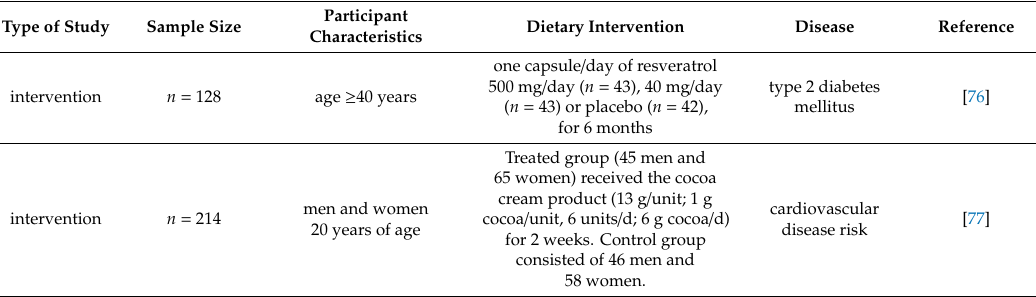
Table 3. Summary of human